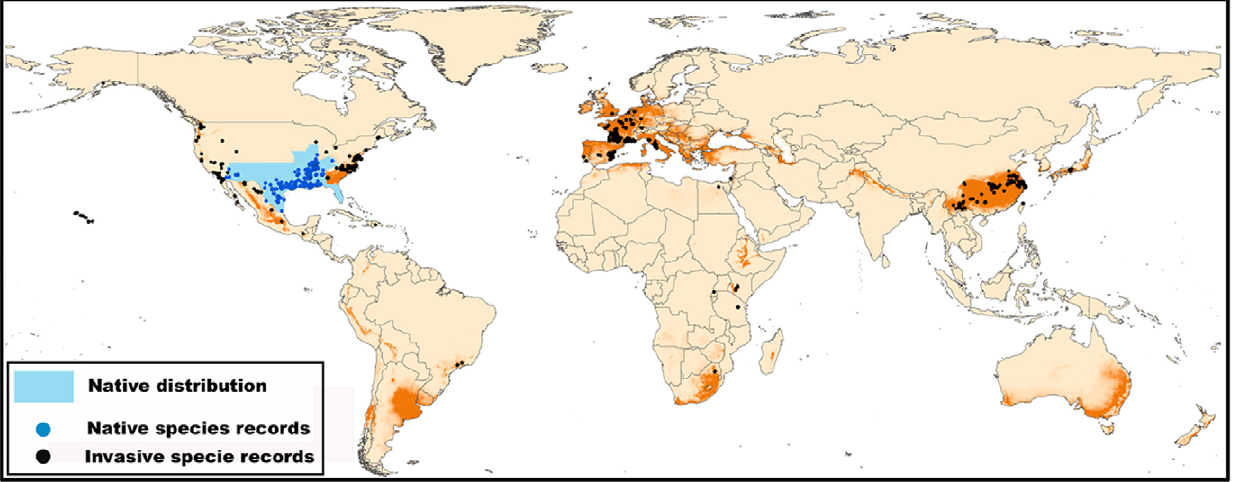
Figure 1. Worldwide projection for the present invasive potential of P.clarkii . The native distribution (blue shading) of P. clarkii and its occurrence is according to ISSG and published references (see Supporting Information Text S1). Black: non-native populations; blue: native populations.